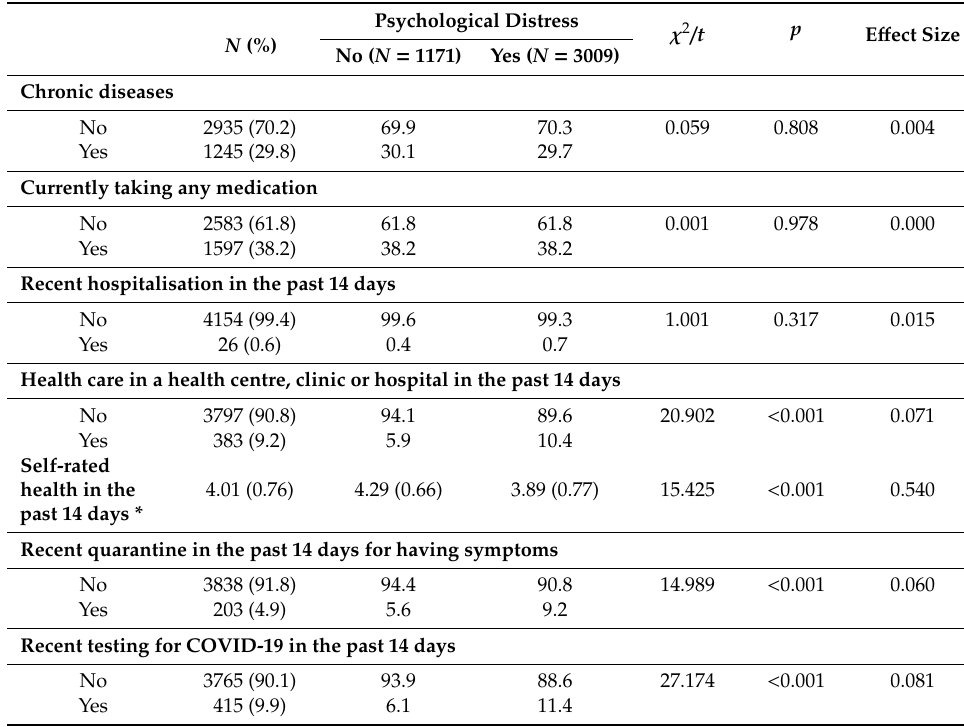
Table 4. Association between health-related variables and psychological distress during the COVID-19 pandemic (N = 4180). Psychological